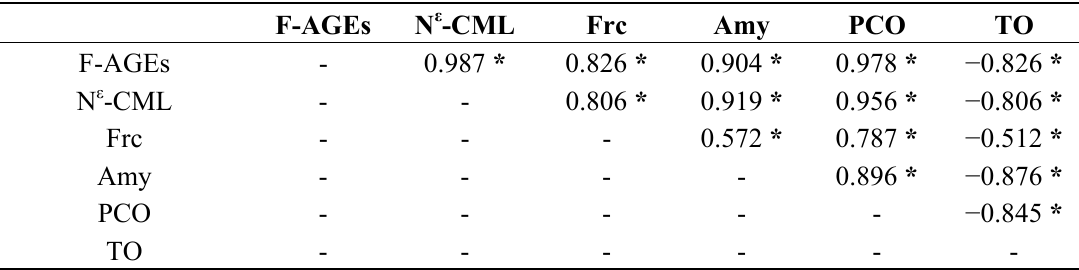
Table 2. Pearson’s correlation coefficients of fluorescence AGEs (F-AGEs), N ε -CML, fructosamine (Frc), amyloid cross β -structure (Amy), protein carbonyl content (PCO), and protein thiol group (TO) level in BSA incubated with the three types of monosaccharides and FA. F-AGEs N ε -CML Frc Amy PCO TO F-AGEs - 0.987 * 0.826 * 0.904 * N ε -CML - - 0.806 * Frc - - - Amy - - - - − 0.876 * PCO - - - - - − 0.845 * TO - - - - - - * Significant at p <